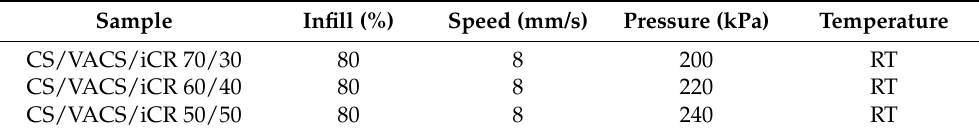
Table 1. Optimum printing parameters of the CS/VACS/iCR